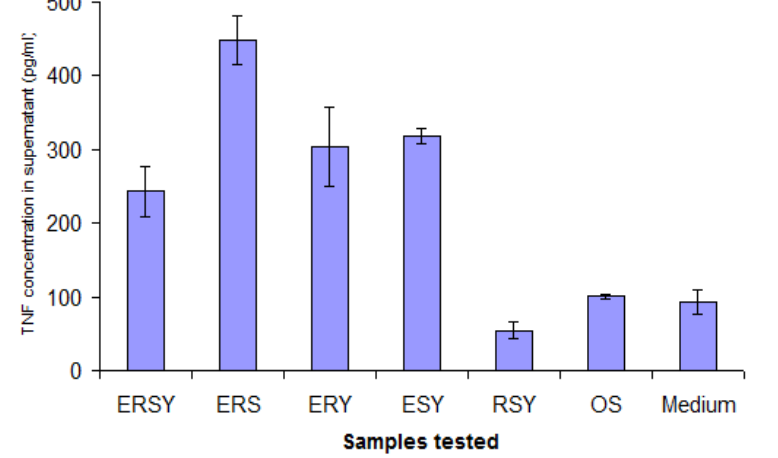
Figure 8. Experiment to determine the requirement (or otherwise) of positively-charged amino acids for stimulatory activity of the EYS combination. OS indicates oleyl sarcosine